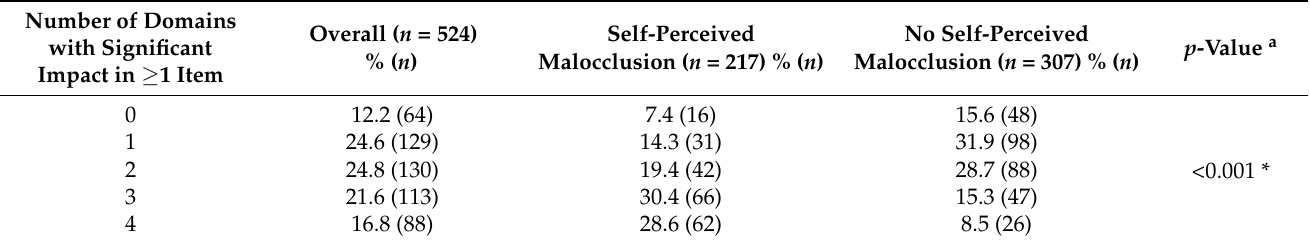
Table 4. Extent of PIDA and its domains amongst the study subjects and by self-perceived malocclusion ( N = 524). Number of Domains with Significant